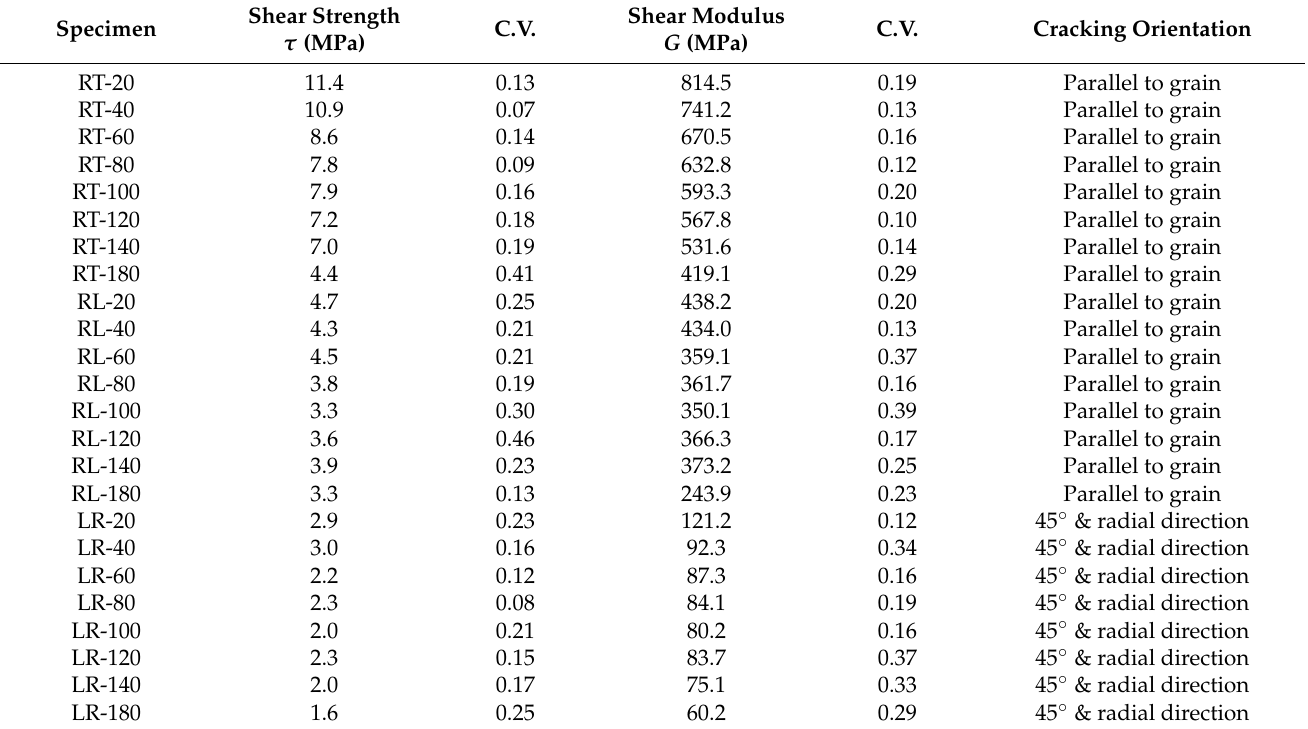
Table 1. Shear strength, shear modulus and cracking details of the tested